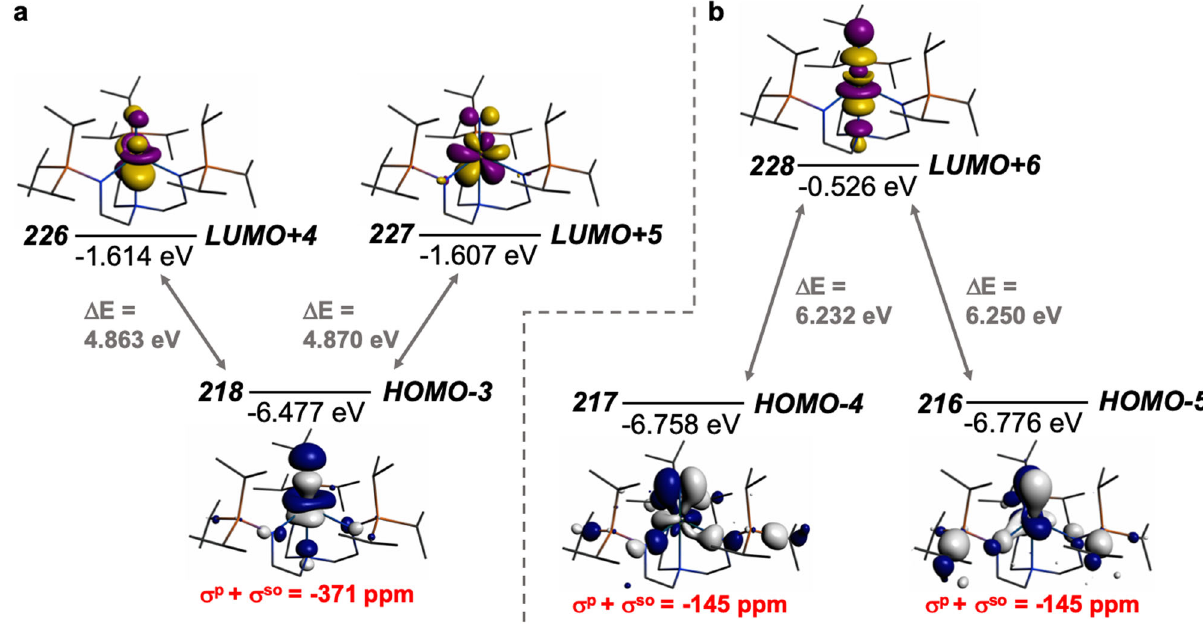
Fig. 4 Dominant occupied and virtual molecular orbitals that contribute to the δ iso value of 1* by magnetic fi eld-induced mixing. a Mixing of the occupied U ≡ N σ -bond with unoccupied U ≡ N π *-bonds. b Mixing of the occupied U ≡ N π -bonds with unoccupied U ≡ N σ *-bond. Hydrogen atoms are omitted for clarity.